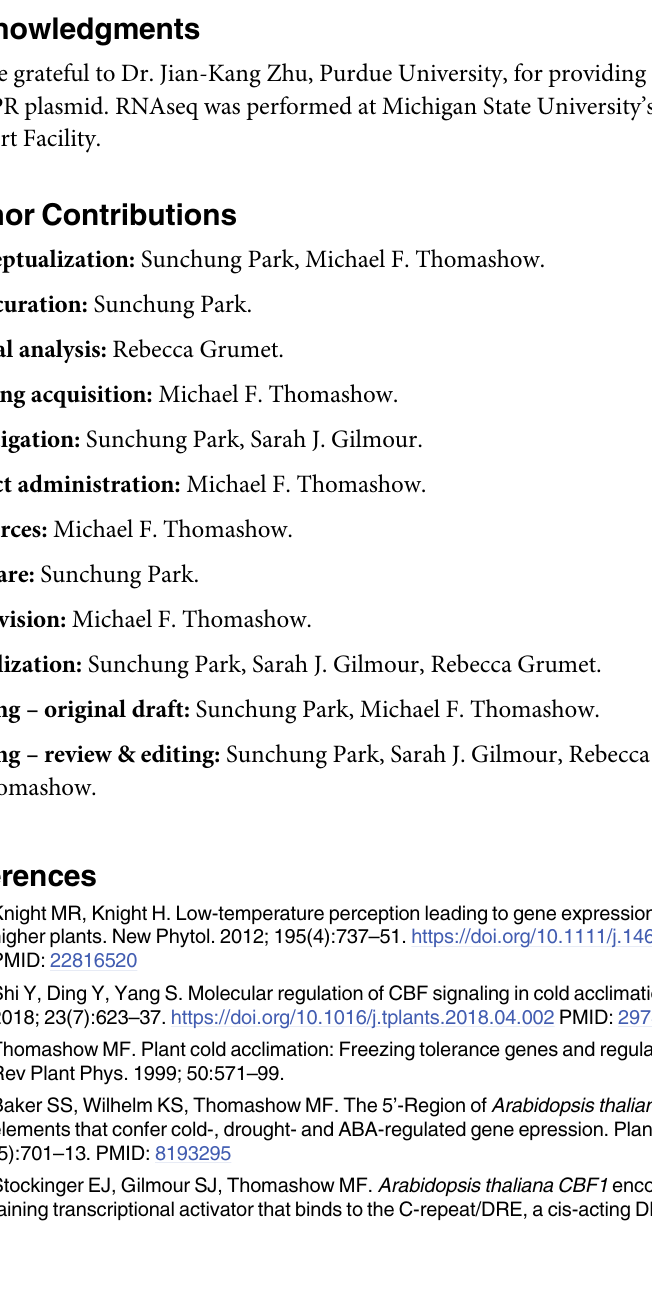
S4 Table. Transcript levels for the 136 Ws-2 CBF regulon genes [14] in SW, sw:cbf 123 , IT and it: cbf123 plants after a 2 week cold treatment. S5 Table. CBF regulon genes of SW, IT and Col-0 plants shown in the Venn diagram pre- sented in Fig 6A. S6 Table. Expression of the 44 common CBF regulon genes in SW, sw: cbf123 , IT, it: cbf123 , Col-0, col-0: cbf123 plants exposed to low temperature for 24